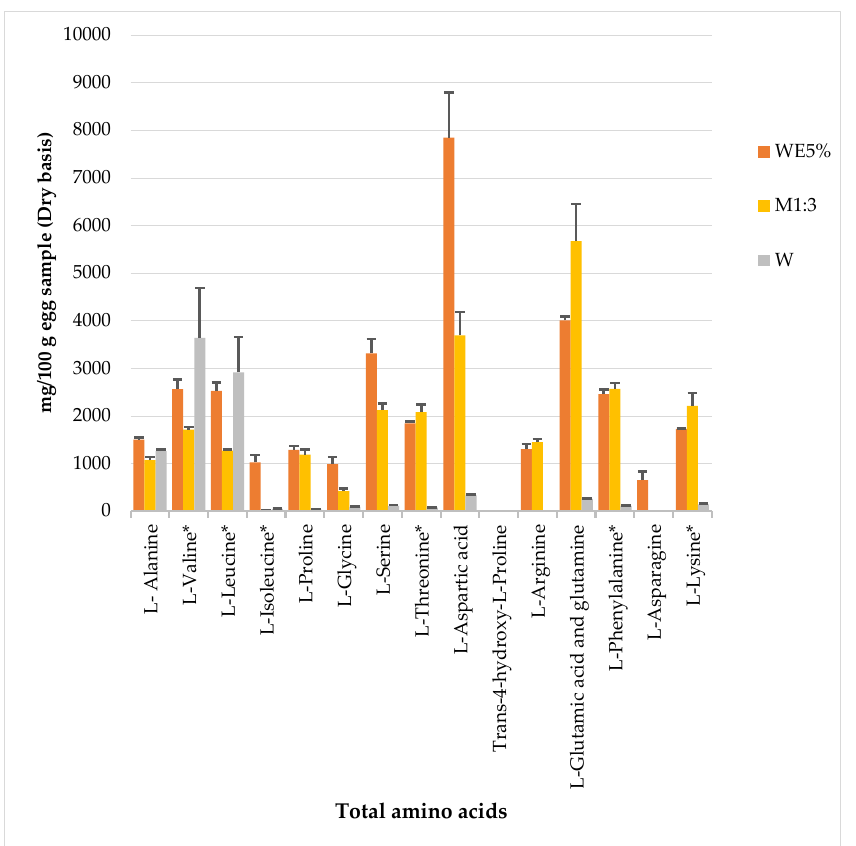
Figure 2. Total amino acid composition of egg powders: whole egg with the addition of 5% sucrose (WE5%); a mixture of 1 part egg yolk and 3 parts egg white (M1:3); and egg white (W). Average data ( n = 2). * Essential amino acids. Bars represent standard deviation.